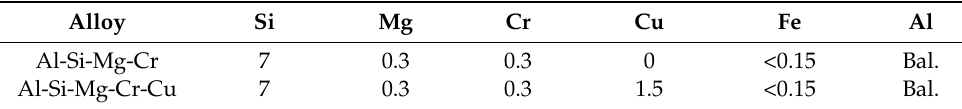
Table 1. Composition of cast aluminum alloys (wt.%).